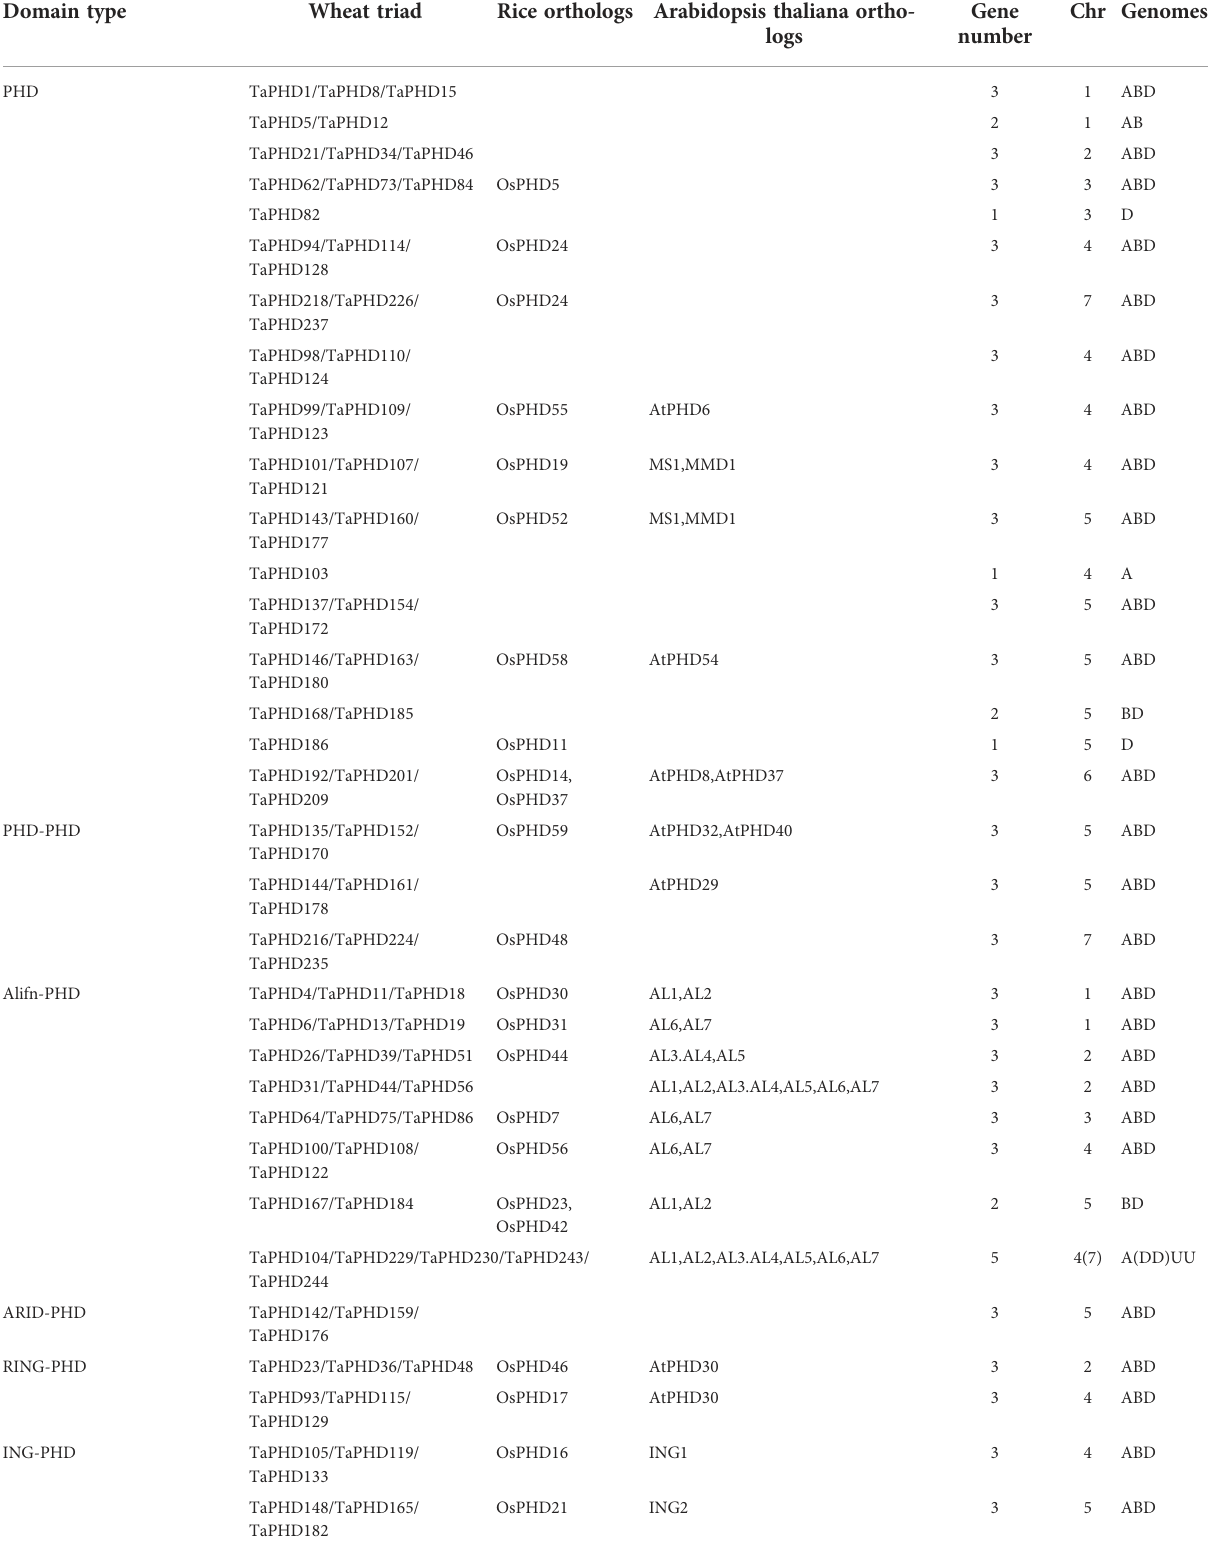
TABLE 1 Types, names, and numbers of wheat PHD- fi nger